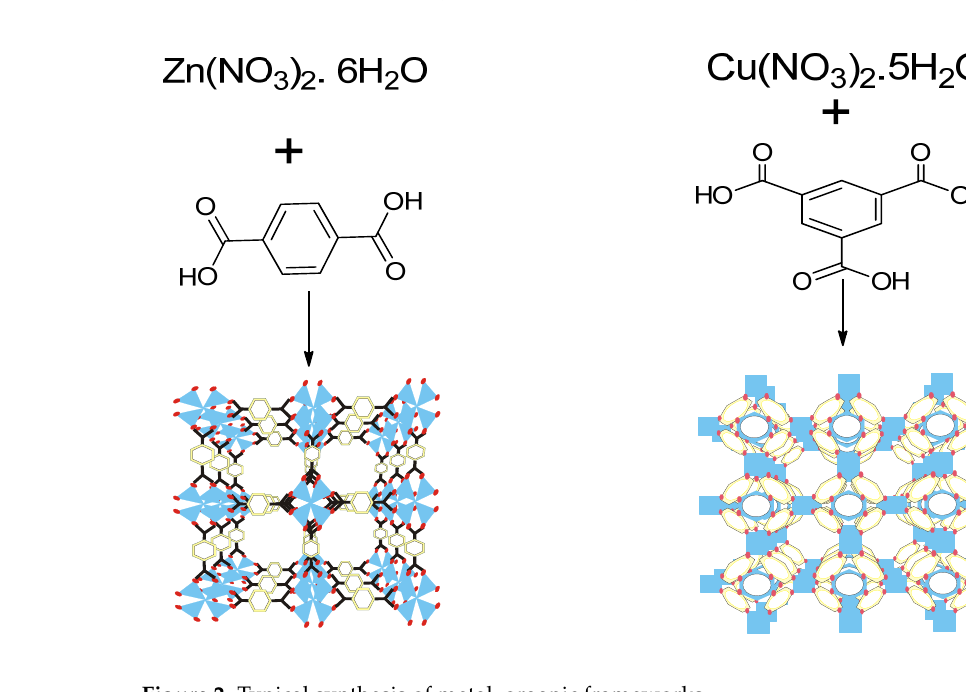
Figure 2. Typical synthesis of metal–organic frameworks.